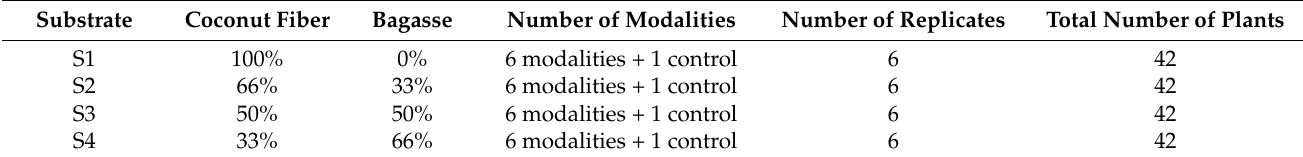
Table 1. Table showing the experimental conditions: 4 different substrates tested (S1, S2, S3, S4), 7 treatments tested (6 modalities + Control), and 6 replicates per treatment. For example, for substrate S1, 42 plants (7 treatments × 6 replicates) were planted. So that gives a total of 168 plants (42 plants per substrate × 4